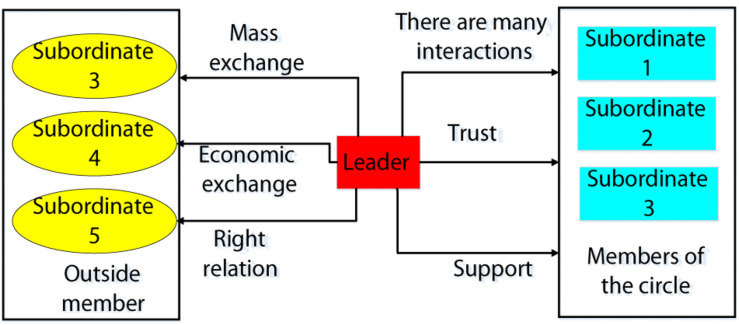
Structure diagram of LMX theory.